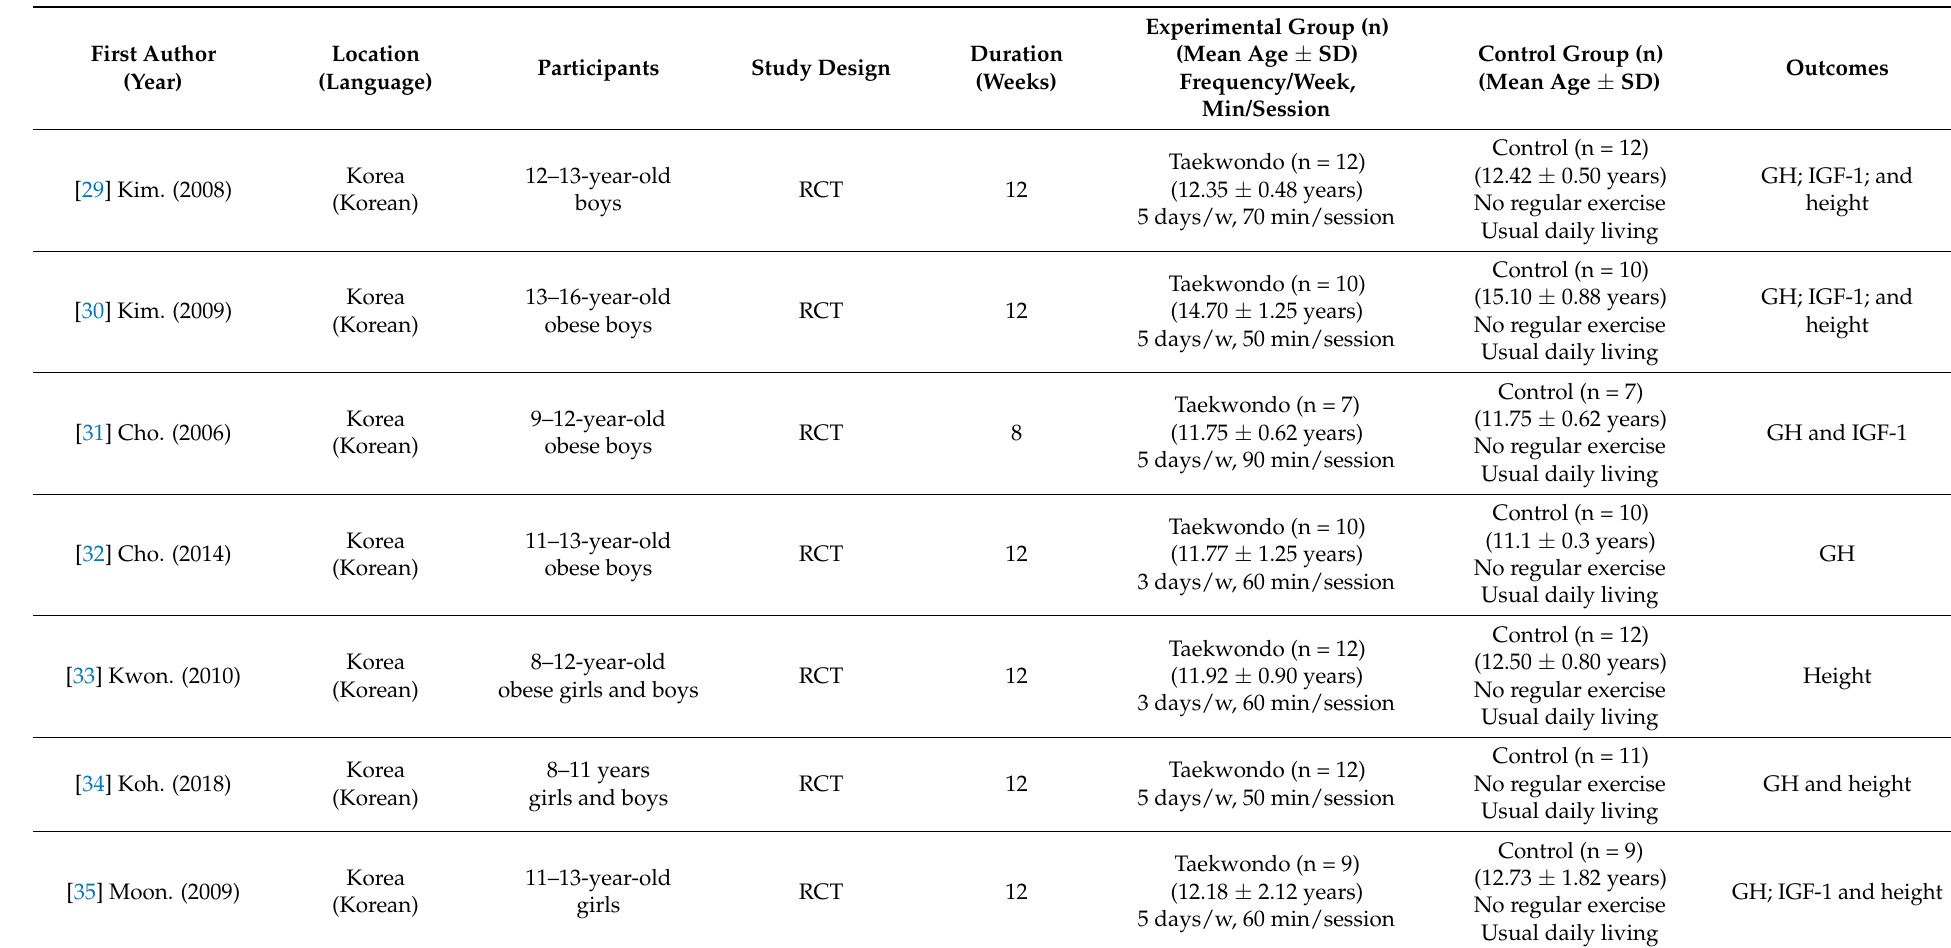
Table 1. Summary of the included